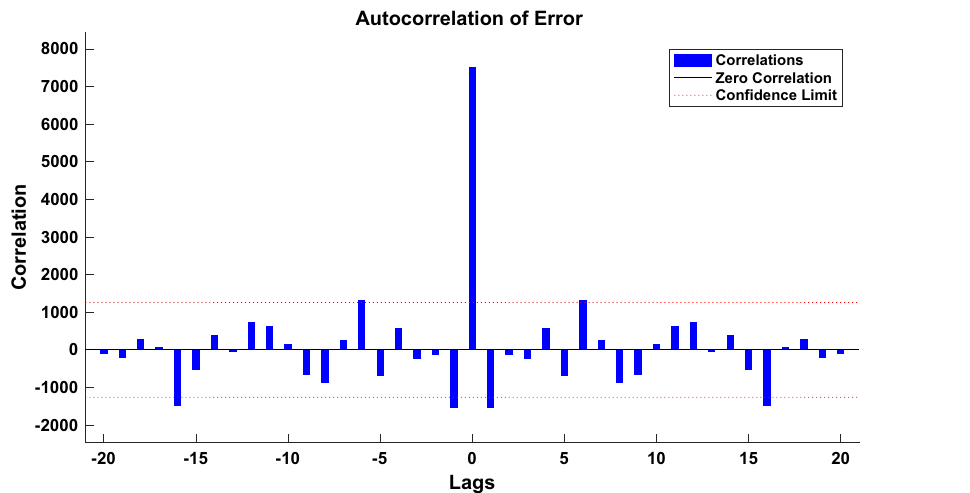
Figure 8. Autocorrelation graph of the residuals of the NARNN model.